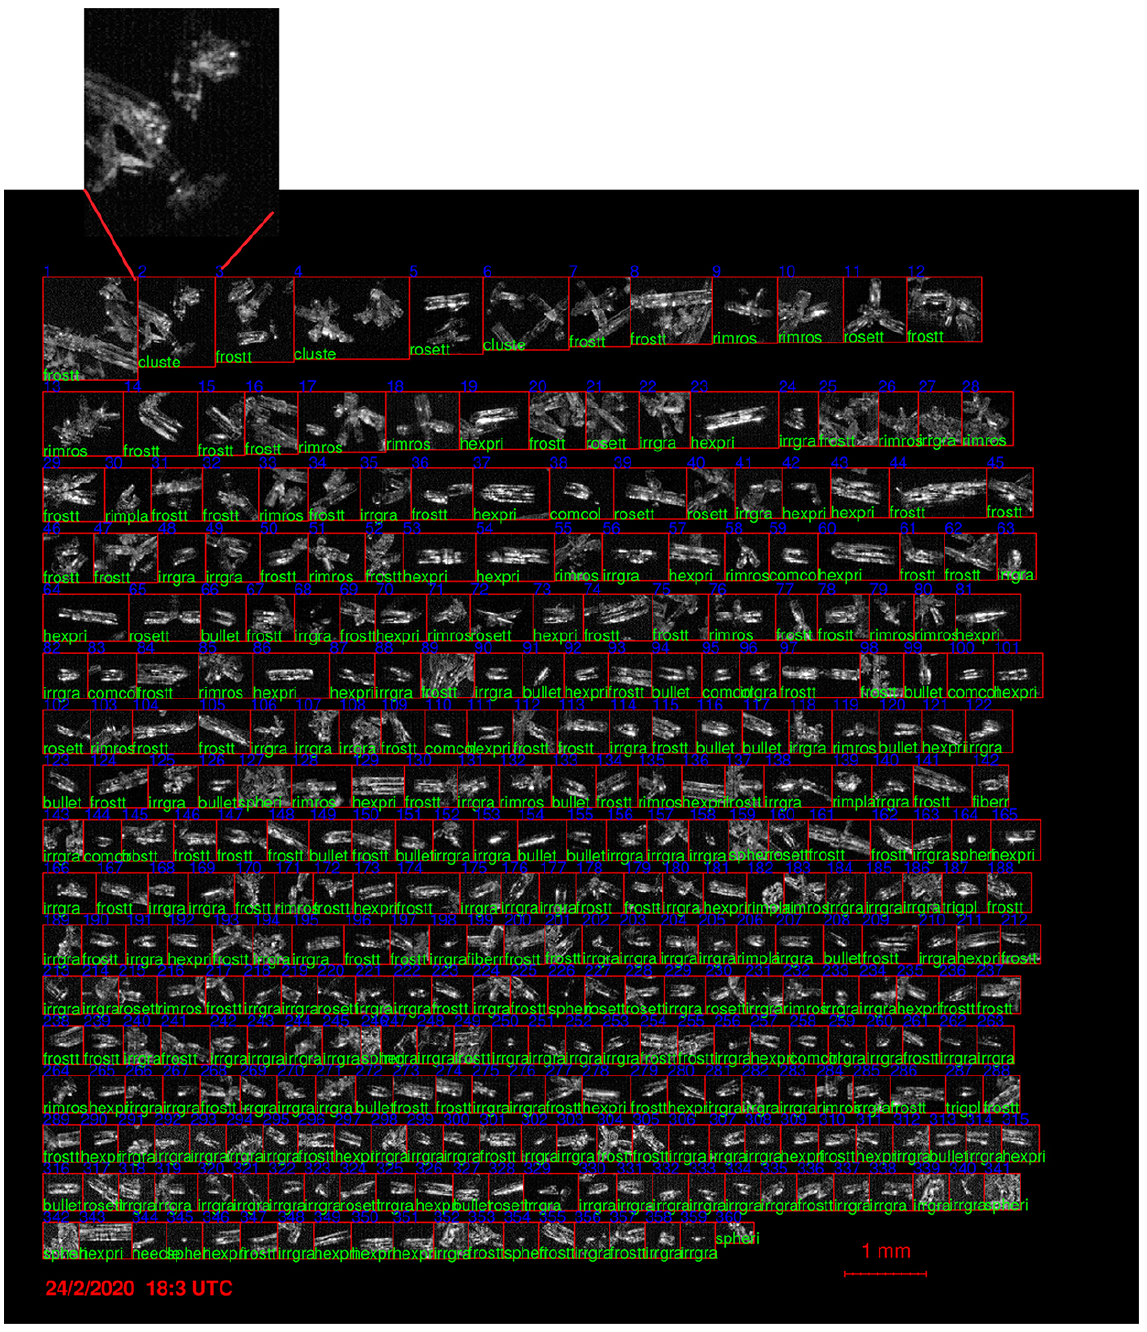
Figure 21. As Fig. 20 still for the day of 24 February 2020, but at 18:03UTC. The photograph indicates a large amount of hexagonal columns and aggregates (or cluster) with a small amount of rimmed rosettes. In the upper part is the zoom of an